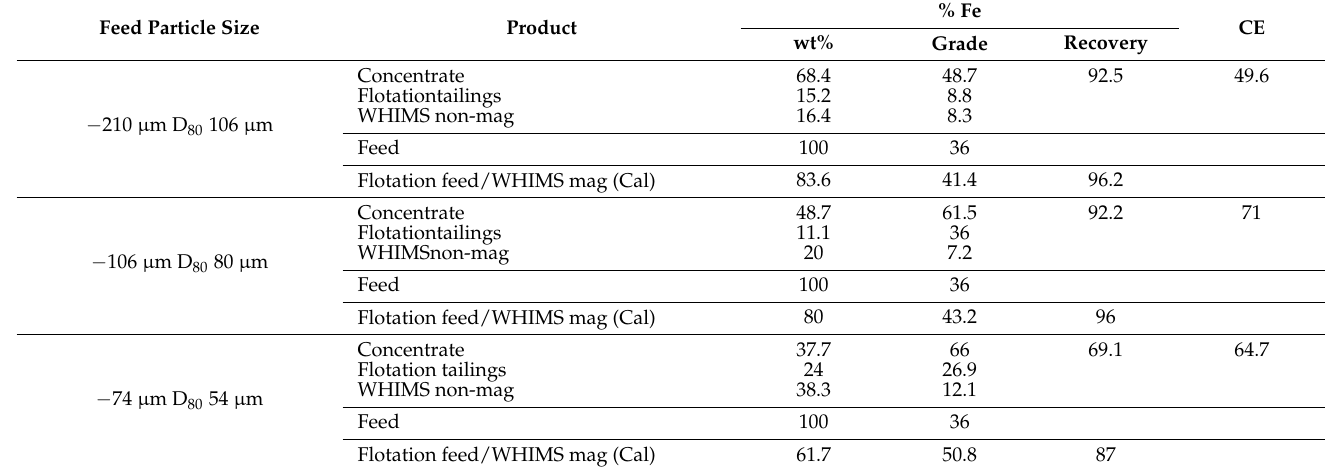
Table 6. Effect of MOG on WHIMS followed by flotation of WHIMS